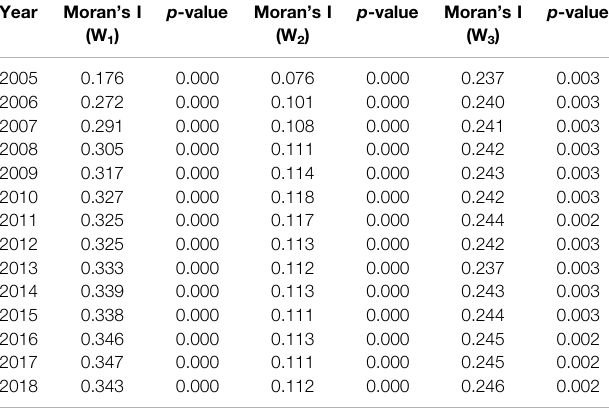
TABLE 5 | Global Moran ’ s I index of the urban consumption